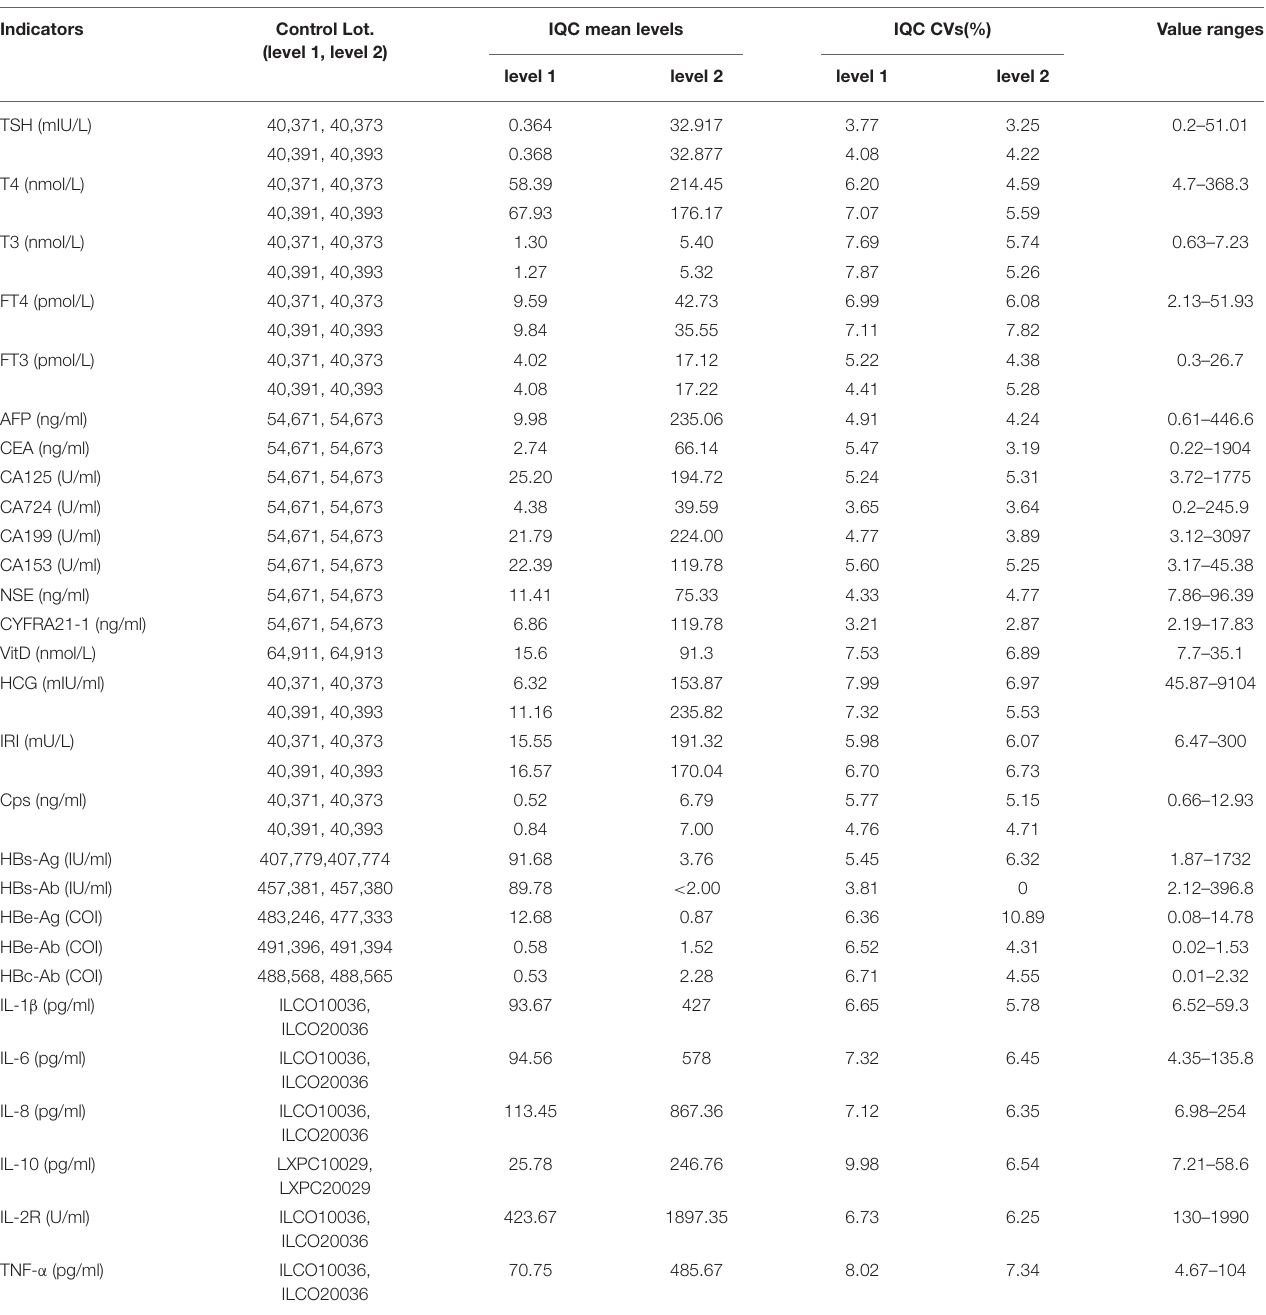
TABLE 1 | The mean levels and CVs of Internal Quality Control (IQC) and value ranges of these indicators.